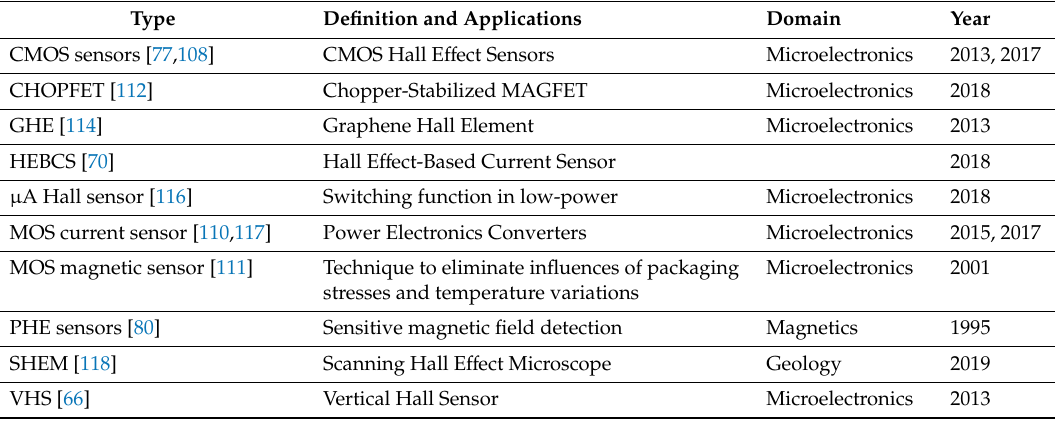
Table 2. Alphabetical summary table of the main known micro devices with integrated Hall E ff ect. Classification is per device